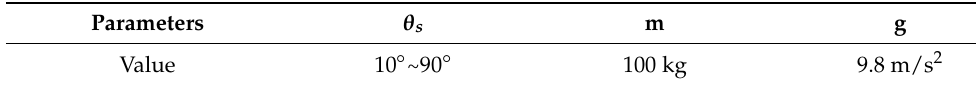
Table 1. The simulation parameters for calculating force F 1